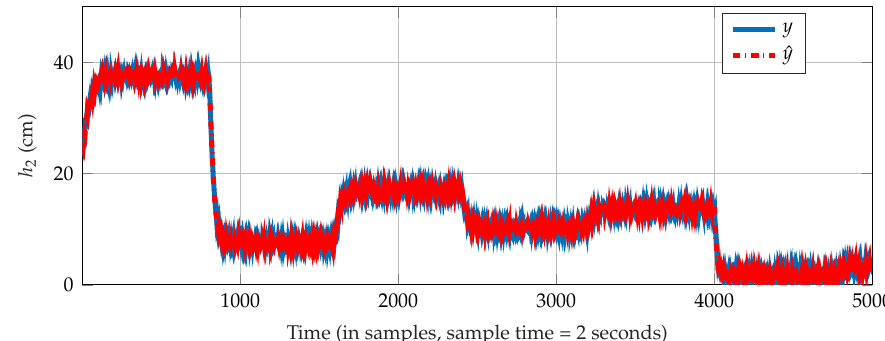
Figure 7. Comparison between the real output ( y ) and the predicted output ( ˆ y ) by the neural network for the tank 2 liquid level.